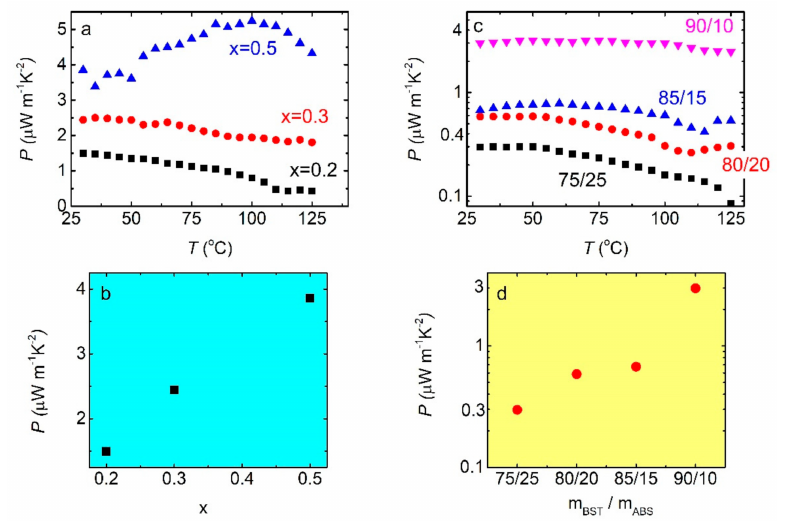
(cid:16) (cid:17) m BST = 80 and for m ABS 20